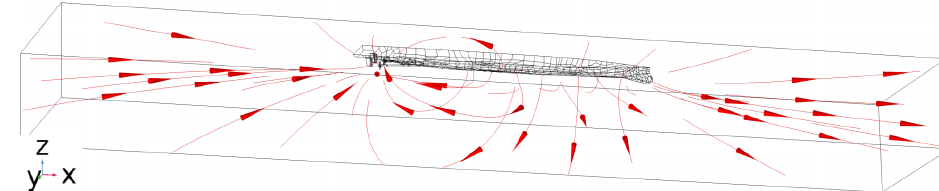
Figure 6. Vector distribution of underwater current density.